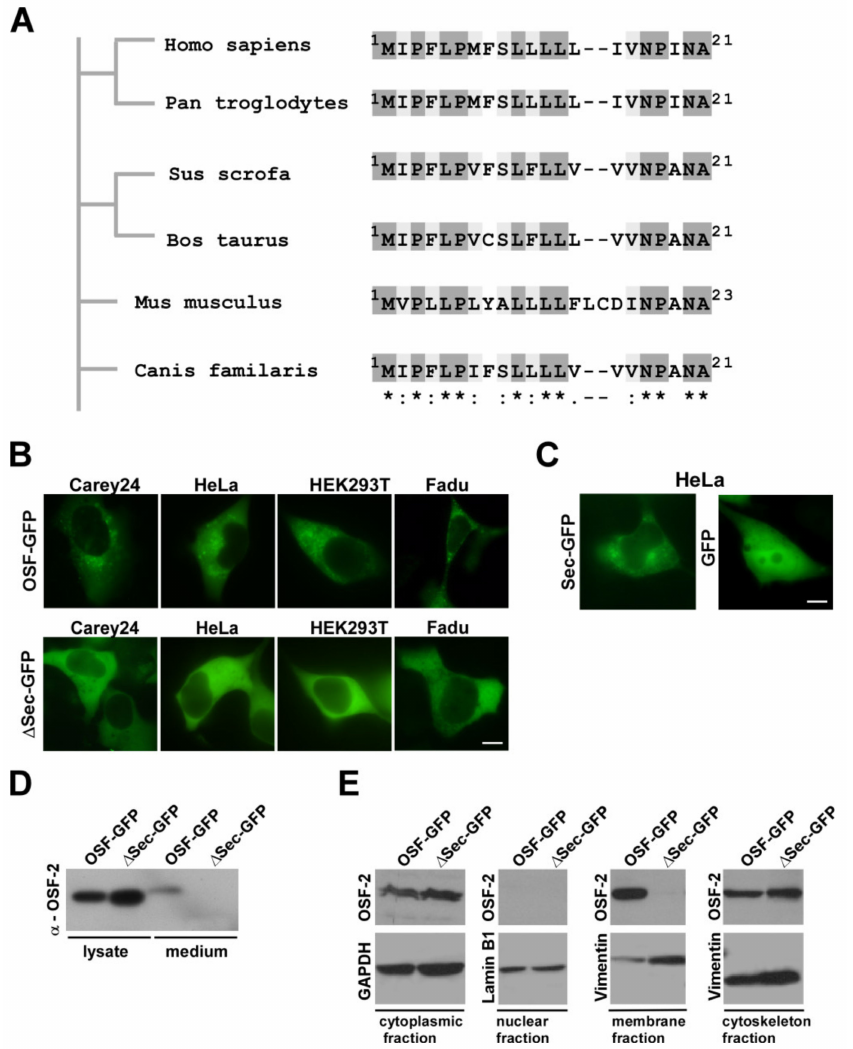
3D-spheroids (Figure 7D,E). Treatment with recombinant OSF-2 significantly increased the number of formed spheroid colonies (Figure 7F).